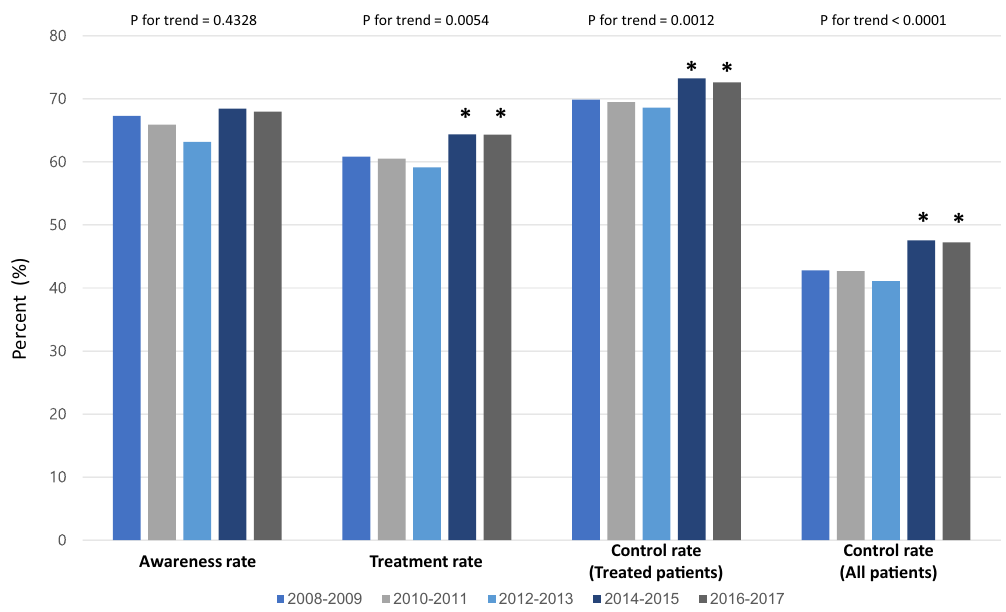
Figure 2. Trends of hypertension awareness, treatment, and control rate from 2008 to 2017. Hypertension treatment and control rate have been significantly improved from 2008–2009 to 2014–2017. *p < 0.05 compared with 2008–2009. Trend analysis was performed by regression analysis and age-adjusted P values are presented.